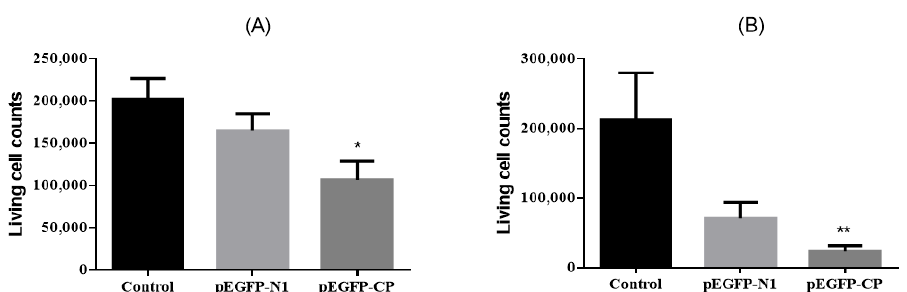
Figure 3. Living cell counts after transfection. ( A ) 24 h post transfection, ( B ) 48 h post transfection